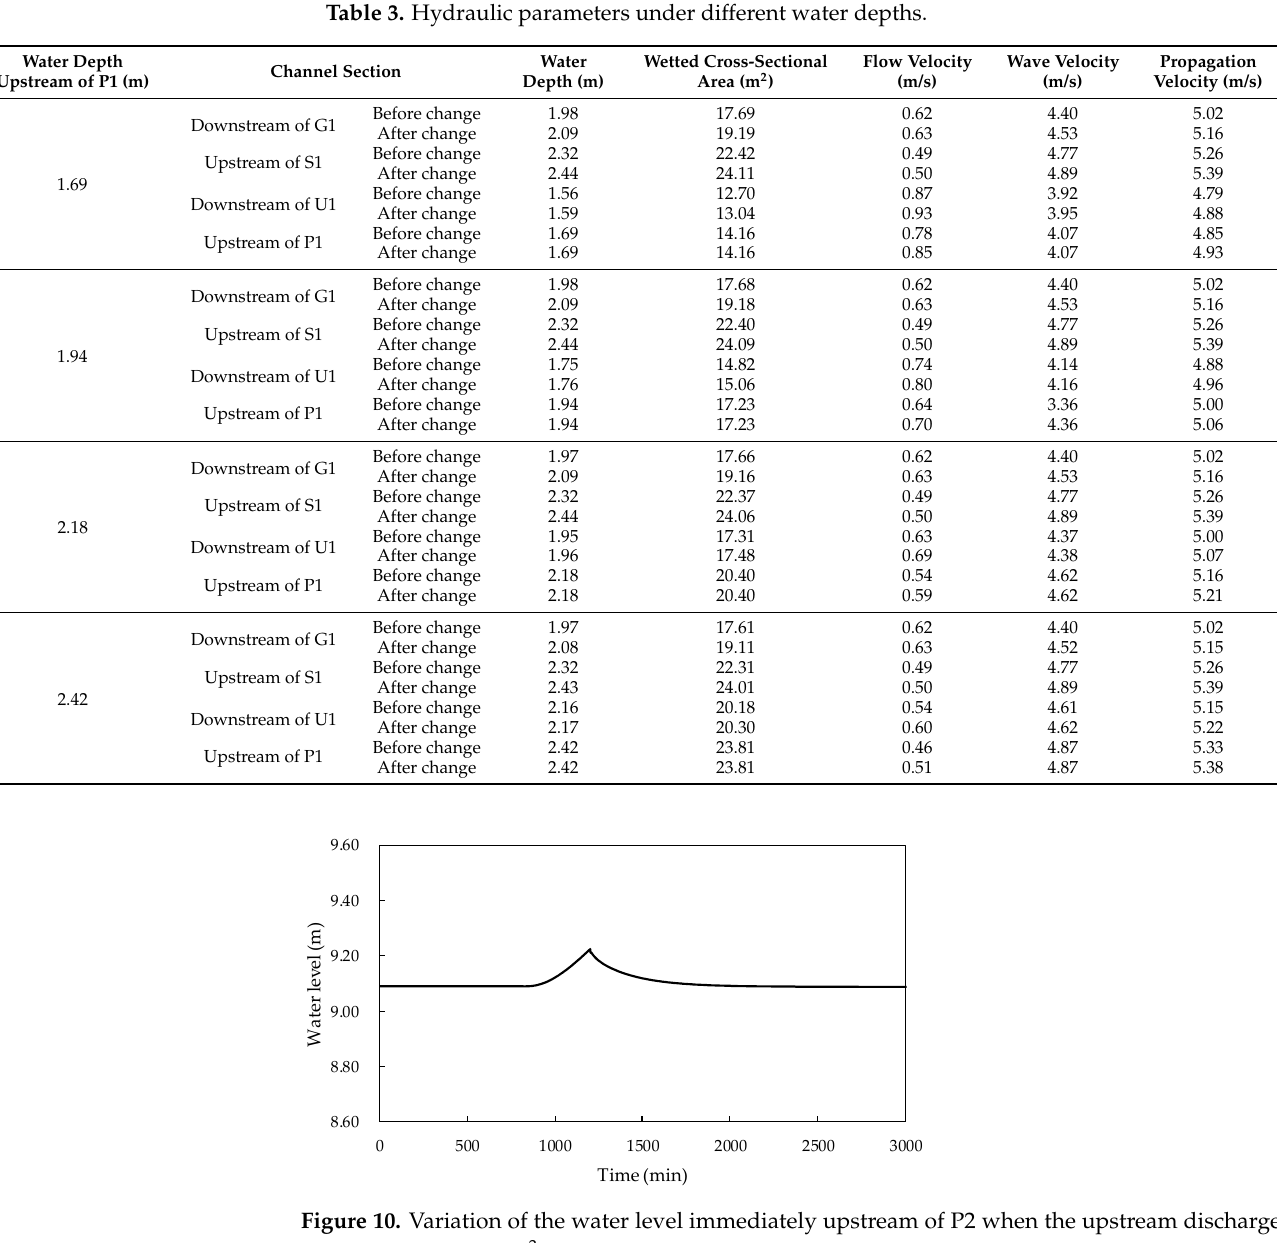
Figure 10. Variation of the water level immediately upstream of P2 when the upstream discharge was increased by 1.1 m 3 /s.